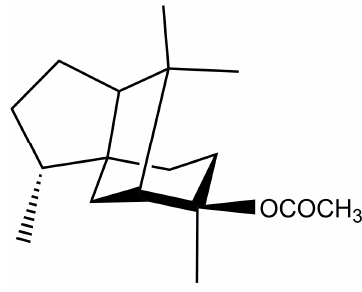
Figure 1. The chemical structure of